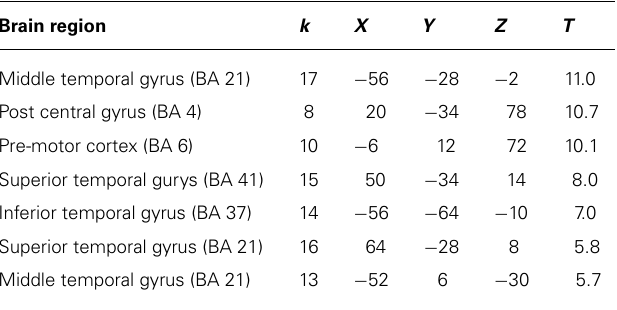
Table 4 | Brain regions and local maxima of clusters, recruited by experts during action decision of successful trials compared to unsuccessful